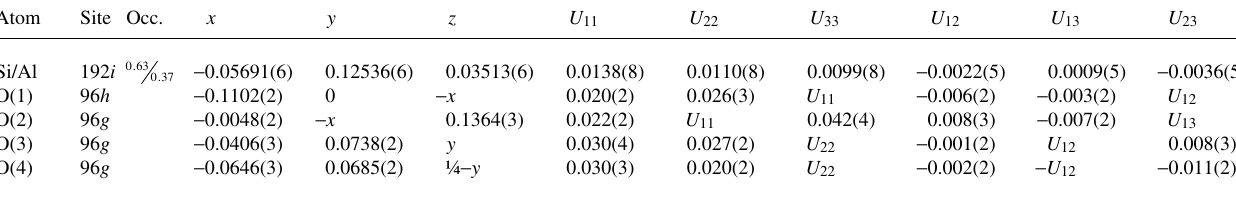
Table 3. Atomic coordinates and displacement parameters (in Å 2 ) .